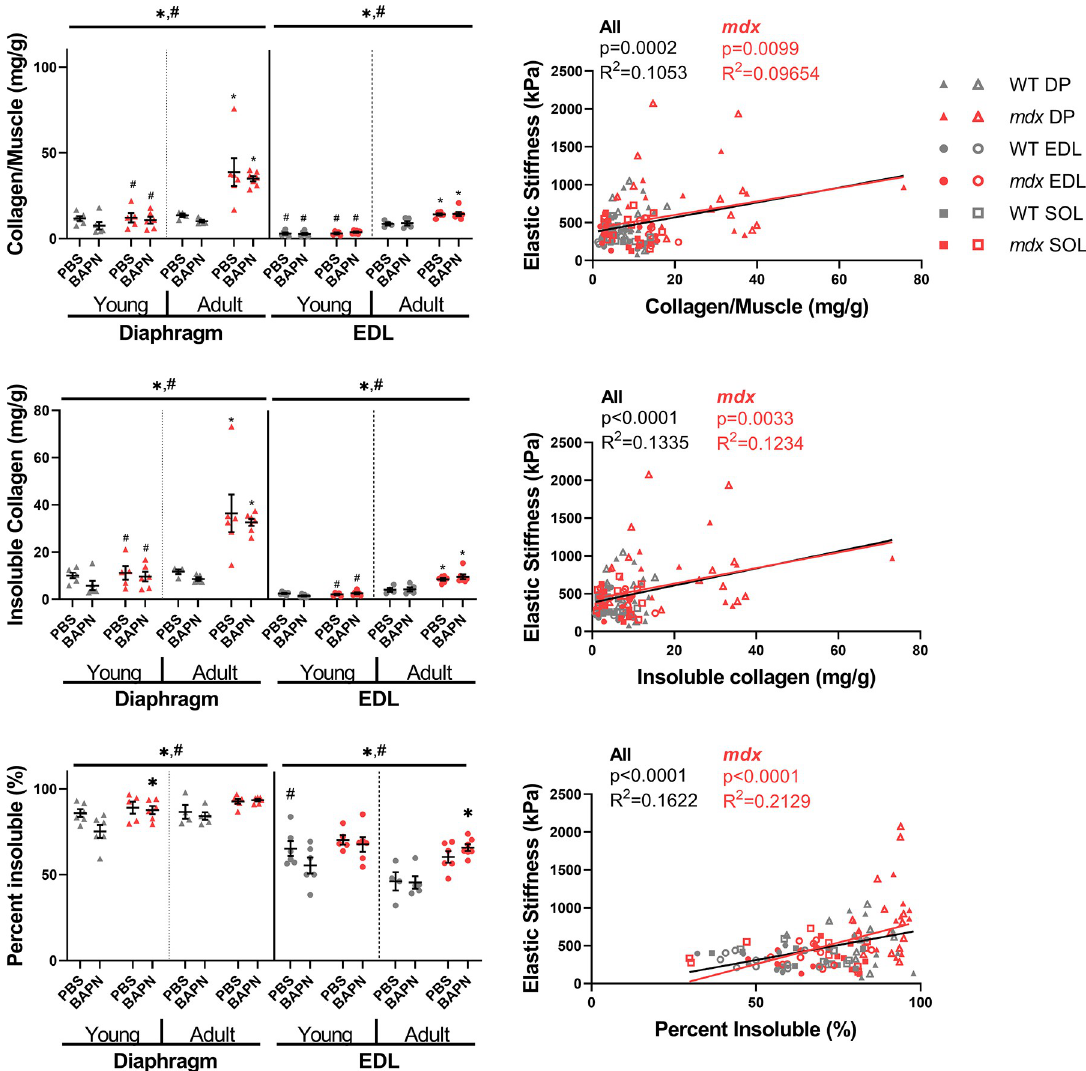
Fig 2. Collagen content and cross-linking. BAPN did not reduce collagen cross-links and the mdx diaphragm showed the most extensive fibrosis in terms of collagen content and cross-links. (A) The amount of collagen per muscle in wildtype and mdx muscles. The diaphragms and EDL muscle collagen content of mdx mice was significantly increased compared with the wildtype. (B) Insoluble (cross- linked) collagen was higher in mdx and adult muscles compared to wildtype. (C) The percentage of collagen that was cross-linked was higher in the mdx diaphragm and EDL muscles compared to the wildtype. Percent insoluble collagen was higher in the adult diaphragm and lower in the adult EDL compared to the respective young muscles. (D-F) Total collagen, insoluble collagen, and percent insoluble collagen scaled with elastic stiffness across all muscles together and the set of mdx points. � = genotype effect, # = age effects, � = p < 0.05 determined by three-way ANOVAs with post-hoc Sidak multiple comparisons